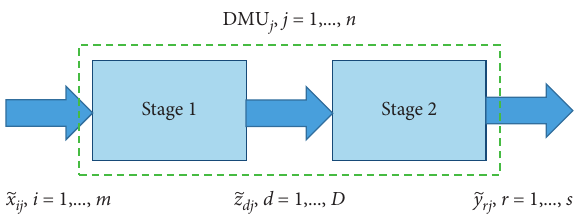
Figure 15: The generic IF two-stage network